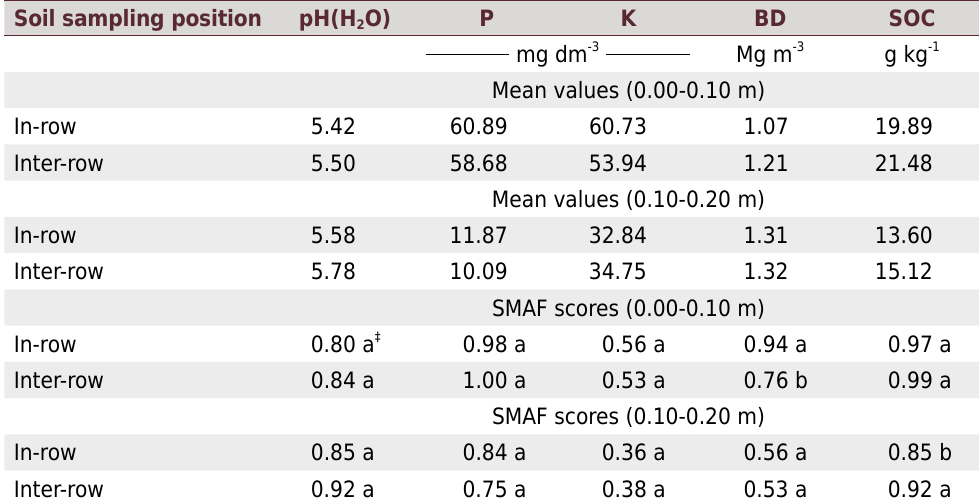
Table 5. Mean values and SMAF scores of soil quality indicators for the 0.00-0.10 and 0.10-0.20 m layers in the row and inter-row position under a long-term no-tillage area Soil sampling